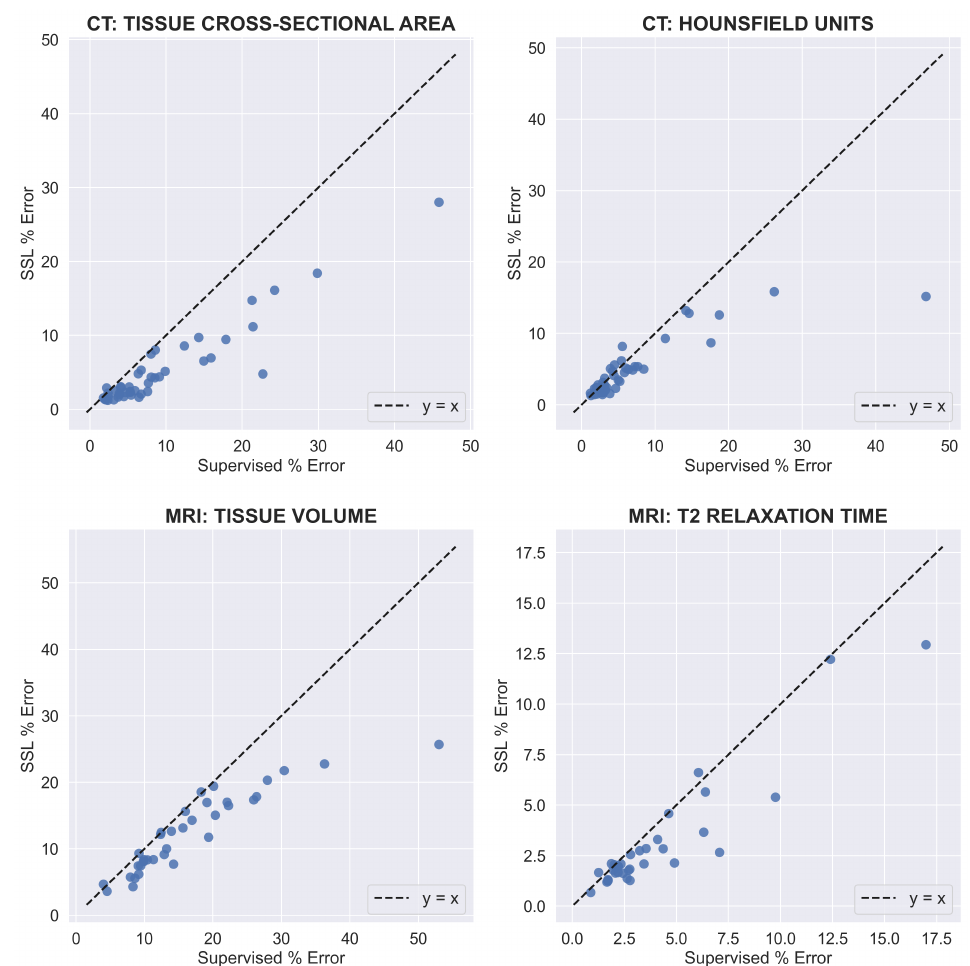
Figure 7. The relationship between the percent error when using supervised learning and the percent error when using SSL. Each blue point represents an image in the test set for the appropriate dataset. The percent error was averaged over all classes and label-limited scenarios. For CT, the intramuscular fat was excluded to prevent large percent error values. For MRI T2 relaxation time, one point with a high percent error for supervised learning was excluded to reduce the range of the